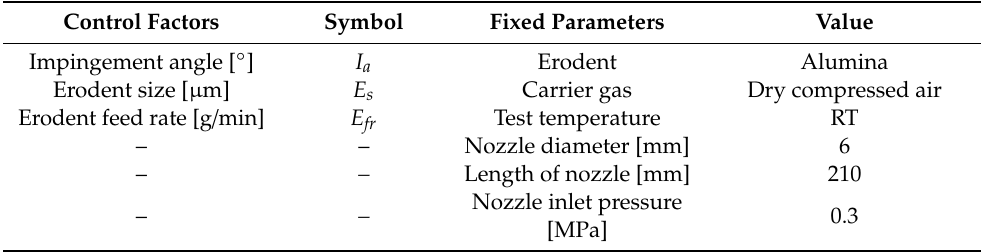
Figure 2. SEM micrographs of the three different sizes of sharp-edged alumina particles: ( a ) 60 μm, ( b ) 90 μm, and ( c ) 200 μm. Table 3. Parameters setup.